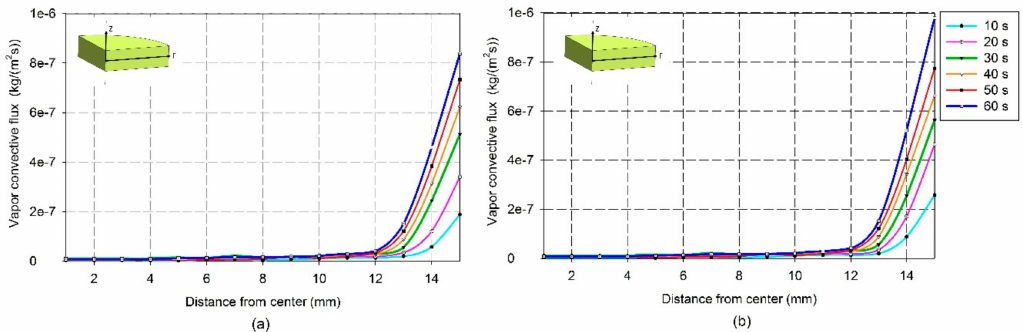
Figure 18. Vapor flux due to gas pressure of ( a ) unripe bananas and, ( b ) ripe